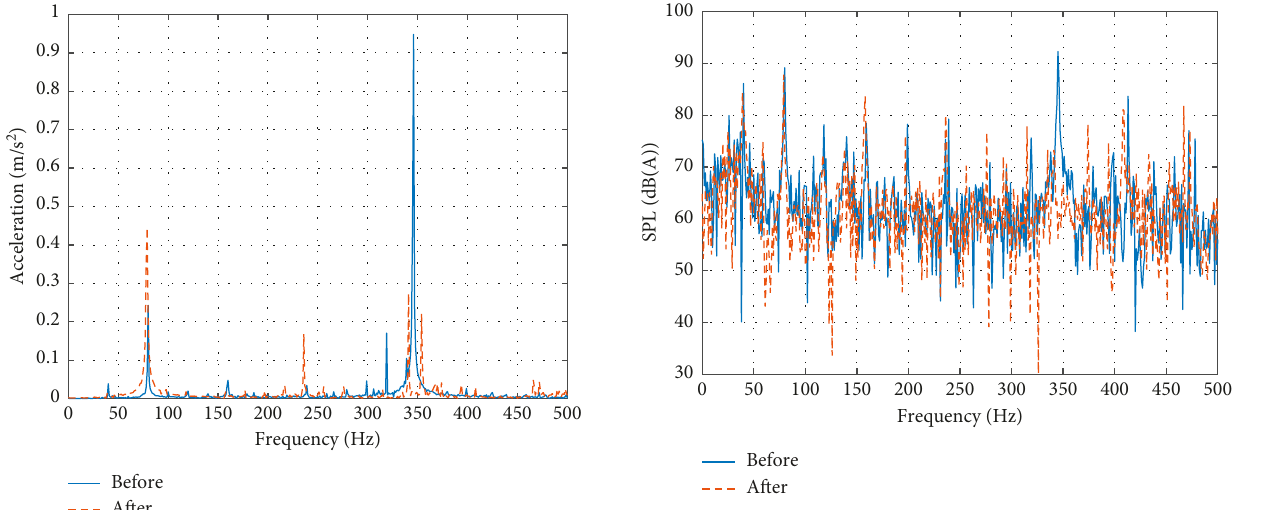
Figure 11: Contrast of parotic noise signals before and after performing structural